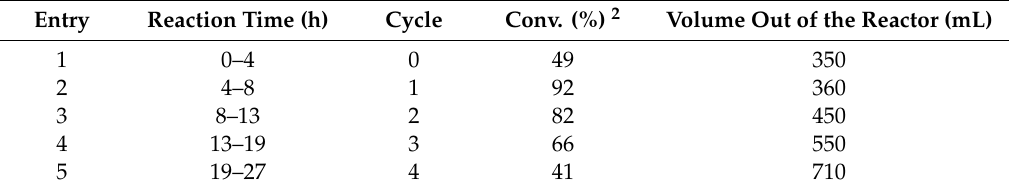
Table 3. Photochemical transformation of 1a to 2a under continuous-flow 1 .